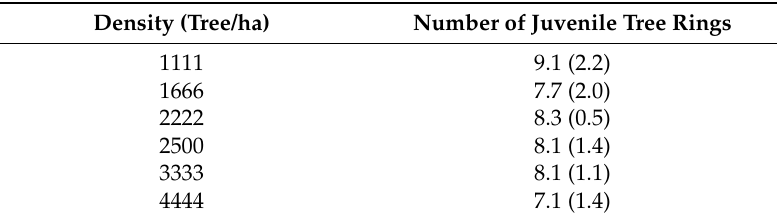
Table 3. Jack pine number of juvenile tree rings (mean (SE)) for each plantation density. Density (Tree/ha)